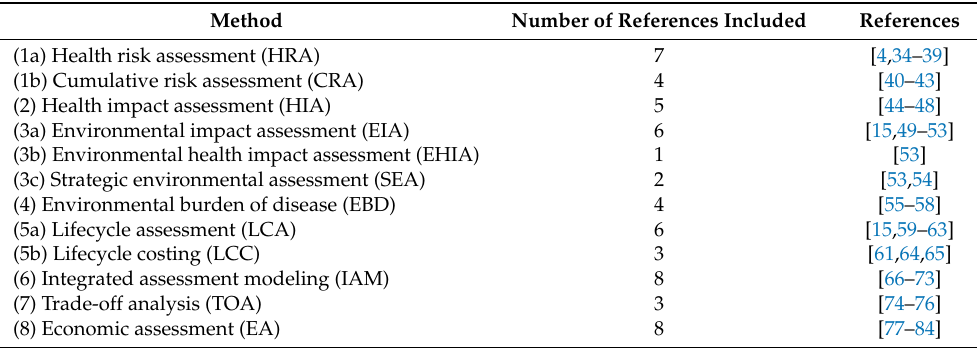
Table 1. The identified methods applicable to assessing the environmental health impacts of an agricultural system and number of references included in the